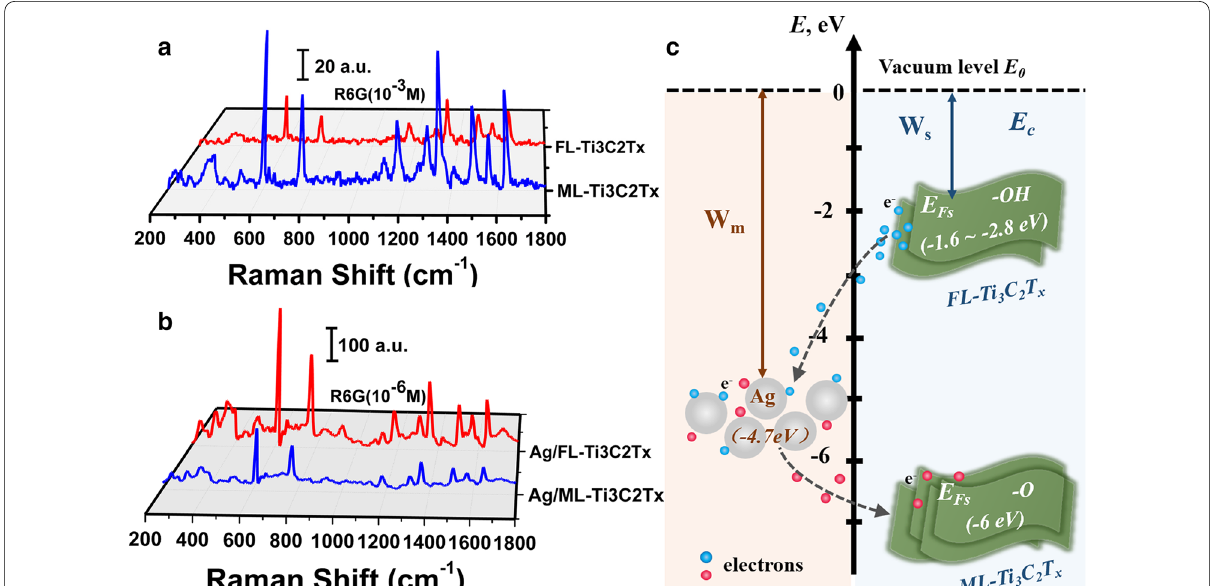
Fig. 4 a SERS spectra of R6G (10 –3 M) with ML‑Ti 3 C 2 T x and FL‑Ti 3 C 2 T x . b SERS spectra of R6G (10 –6 M) with Ag/ML‑Ti 3 C 2 T x and Ag/FL‑Ti 3 C 2 T x . c Schematic diagram of electron transfer from FL‑Ti 3 C 2 T x to Ag NP due to their work function difference. W m and W s represent the work functions of Ag NP and